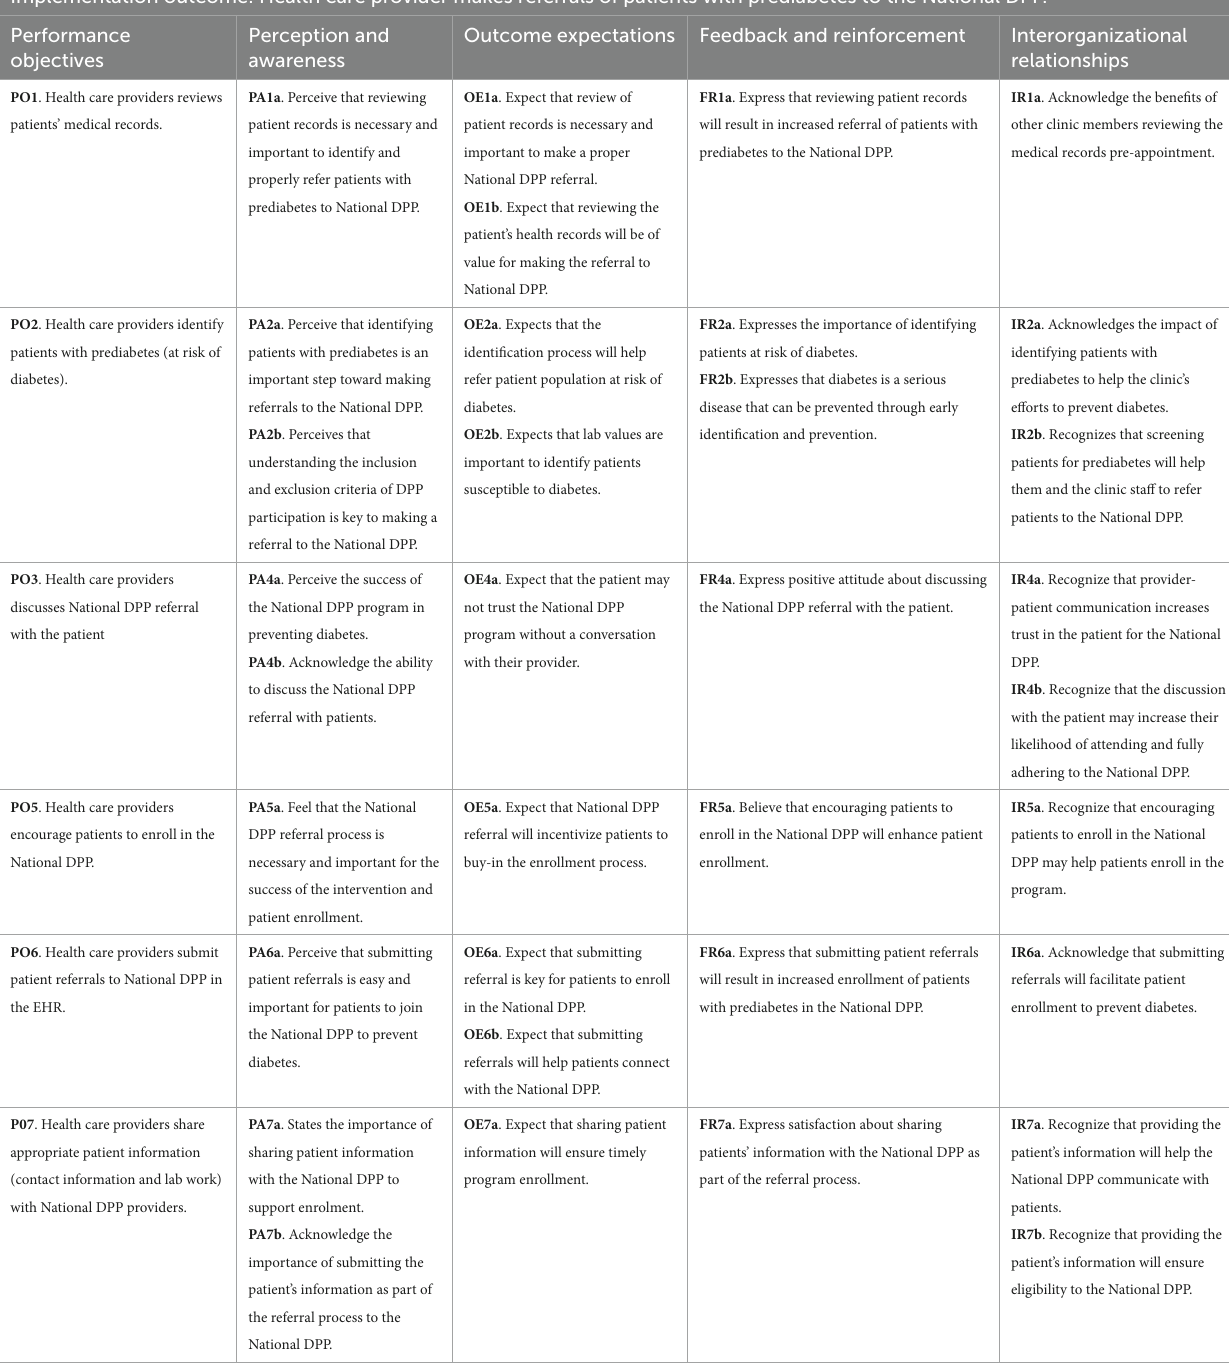
TABLE 4 Sample matrices of change objectives for the implementation of the National Diabetes Prevention Program among participating clinics in Texas, United States. Implementation outcome: Health care provider makes referrals of patients with prediabetes to the National DPP. Performance